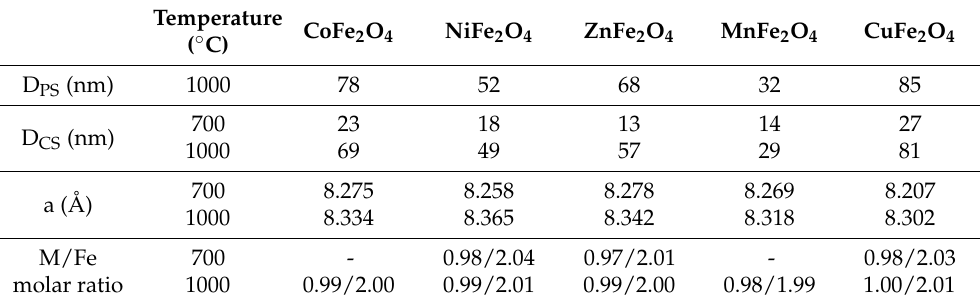
Table 1. Average particle size (D PS ), average crystallite size (D CS ), lattice parameter (a) and